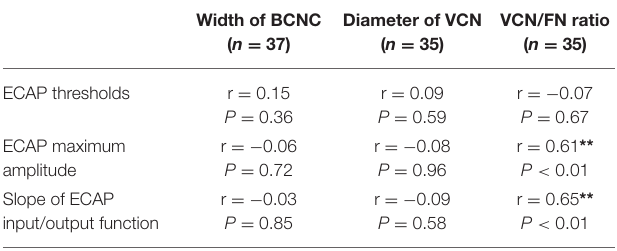
TABLE 2 | Correlation of bone cochlear nerve canal (BCNC) width, vestibulocochlear nerve (VCN) diameter and VCN to facial nerve (FN) ratio to ECAP threshold, ECAP maximum amplitude and slope of ECAP Input/Output